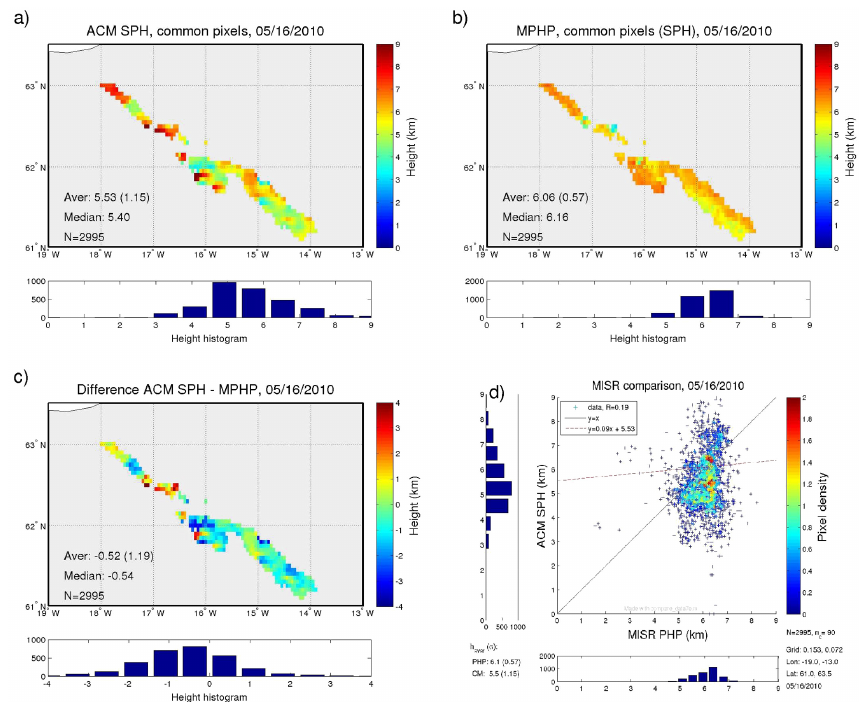
Figure 11. The MPHP and ACM (SPH) plume heights and their difference, limited by both the MPHP plume and AATSR-detected ash plume (BTD < 0K). AATSR gives 0.5km lower heights on average, with significantly more variation ( σ h = 0 . 6km for MISR and σ h = 1 . 2km for AATSR), as can be seen from the height histograms (below the height maps). The differences are centered roughly on 0, but the scatterplot shows poor pixel-by-pixel correlation ( R = 0 . 2) between the